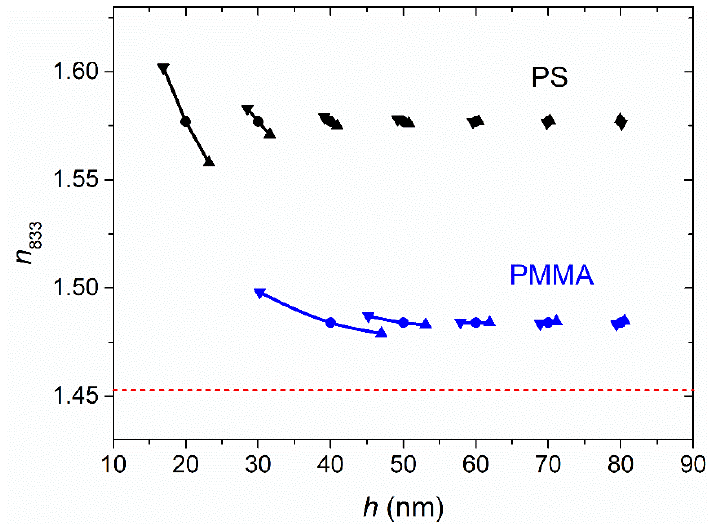
Figure 6. Changes in n 833 and h of PS and PMMA films due to a systematic error of ± 0.0001 in absorbance (triangles pointing up for data with error +0.0001 and triangles pointing down for data with error − 0.0001). The substrate n 833 has also been included (red dashed line).